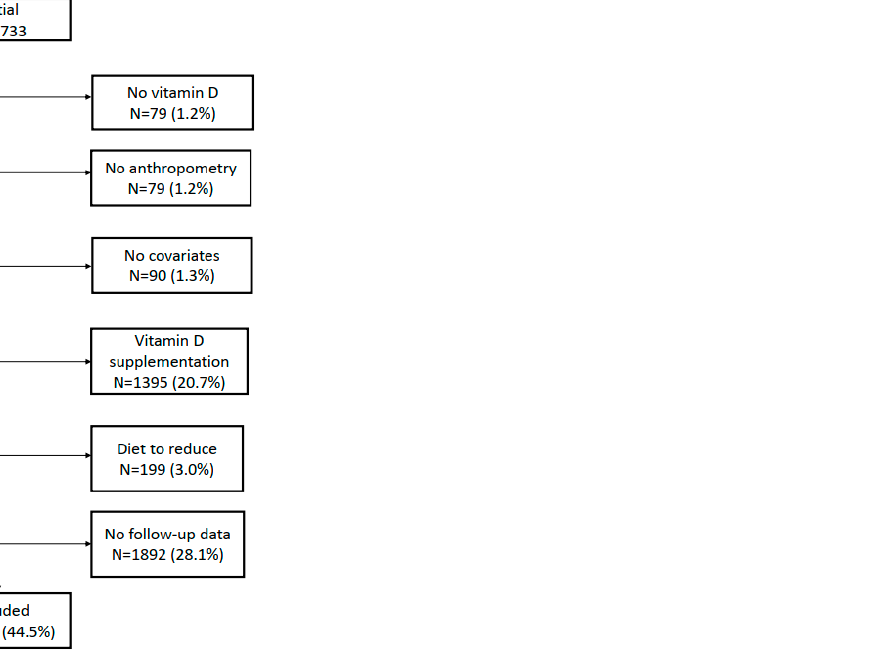
Figure 2. Selection of participants for the 10-year follow-up, CoLaus|PsyCoLaus study, Lausanne, Switzerland.